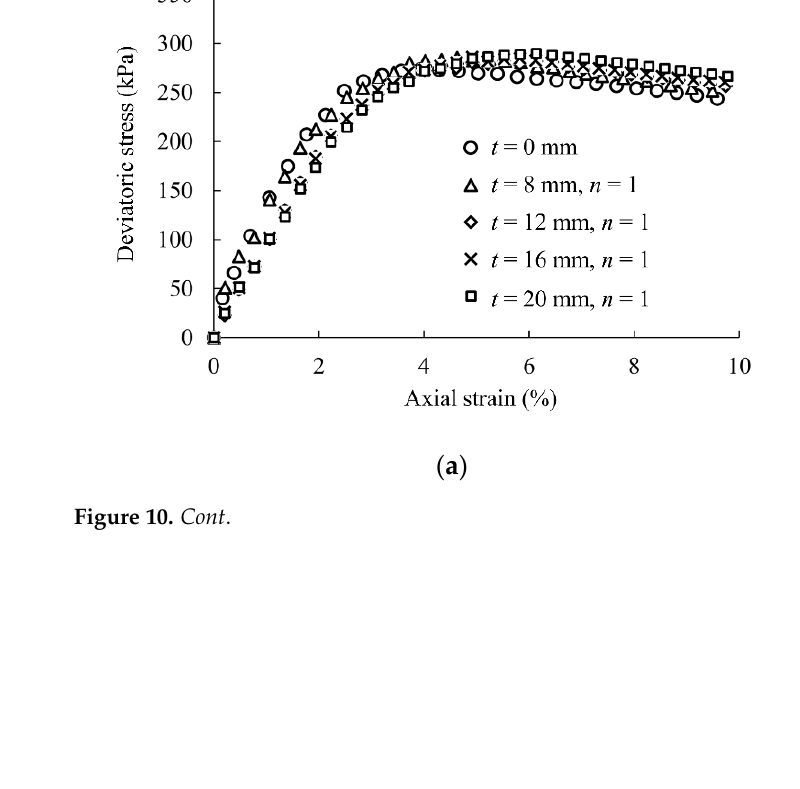
( b ) ( c ) Figure 10. The deviatoric stress–axial strain curves of the LGSCR samples at different thicknesses of sand layers and confining pressures of ( a ) 150 kPa, ( b ) 250 kPa, and ( c ) 400 kPa. Furthermore, the obtained deviatoric stress–axial strain curves are compared with those of the non-woven-geotextile-reinforced sand samples under triaxial compression